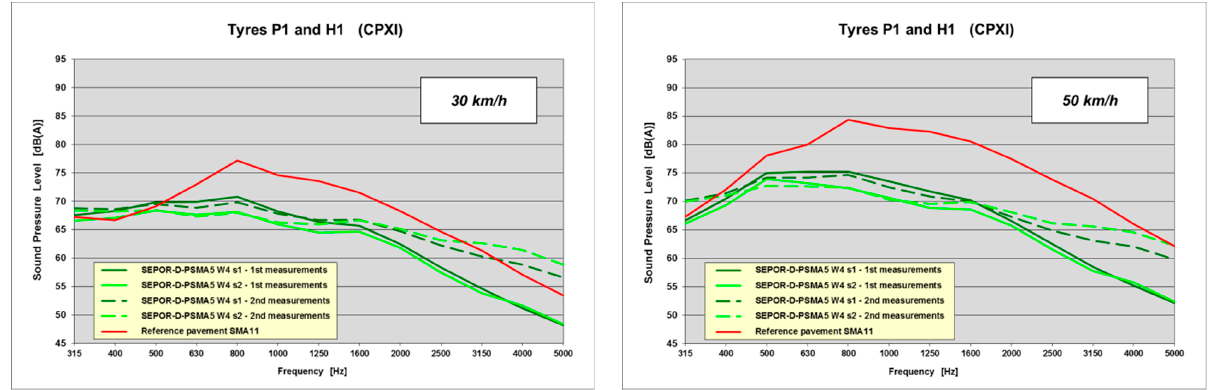
Figure 23. Frequency spectra of poroelastic wearing course placed at the D ą brówka long test section.